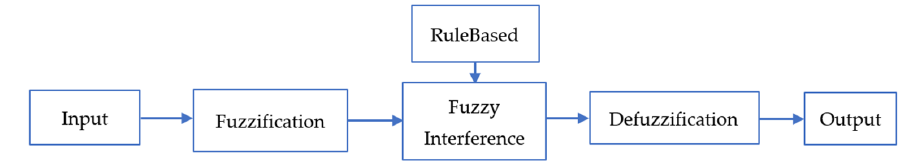
Figure 2. Overview of a fuzzy logic ‐ based controller.